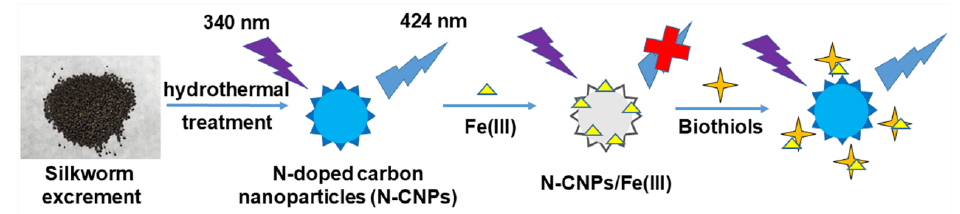
Figure 1. A schematic illustration of the formation of N-CNPs from silkworm excrement, and the fluorescence “on–off–on” detection of Fe(III) and biothiols.